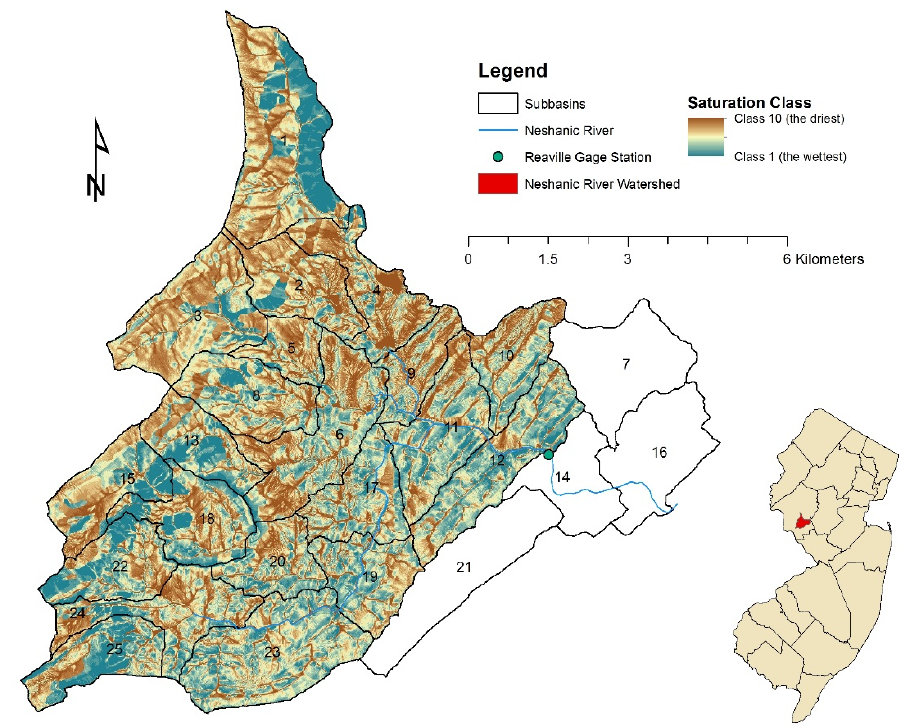
Figure 2. The spatial distribution of TI in the Neshanic River